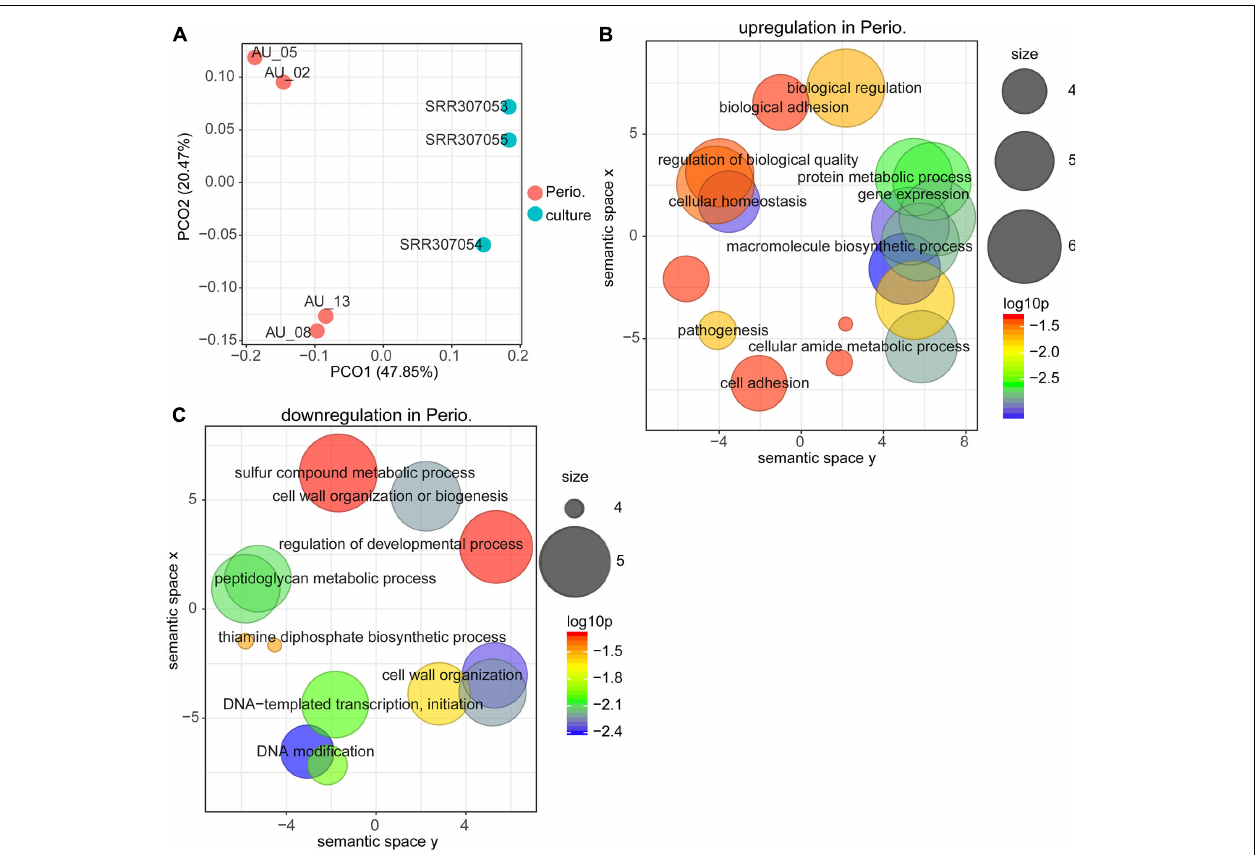
FIGURE 1 | Comparison between gene expression in periodontitis and laboratory culture for Porphyromonas gingivalis. (A) Principal coordinates analysis (PCoA) of transcriptional profiles from four periodontal pocket samples (chronic periodontitis) and laboratory cultures on three different media. (B,C) Gene ontology (GO) terms up-regulated (B) and down-regulated (C) in periodontitis. All GO terms with enrichment P -value ≤ 0.05 were summarized and visualized by REVIGO (Supek et al., 2011), and the size of the bubble indicates the number of merged